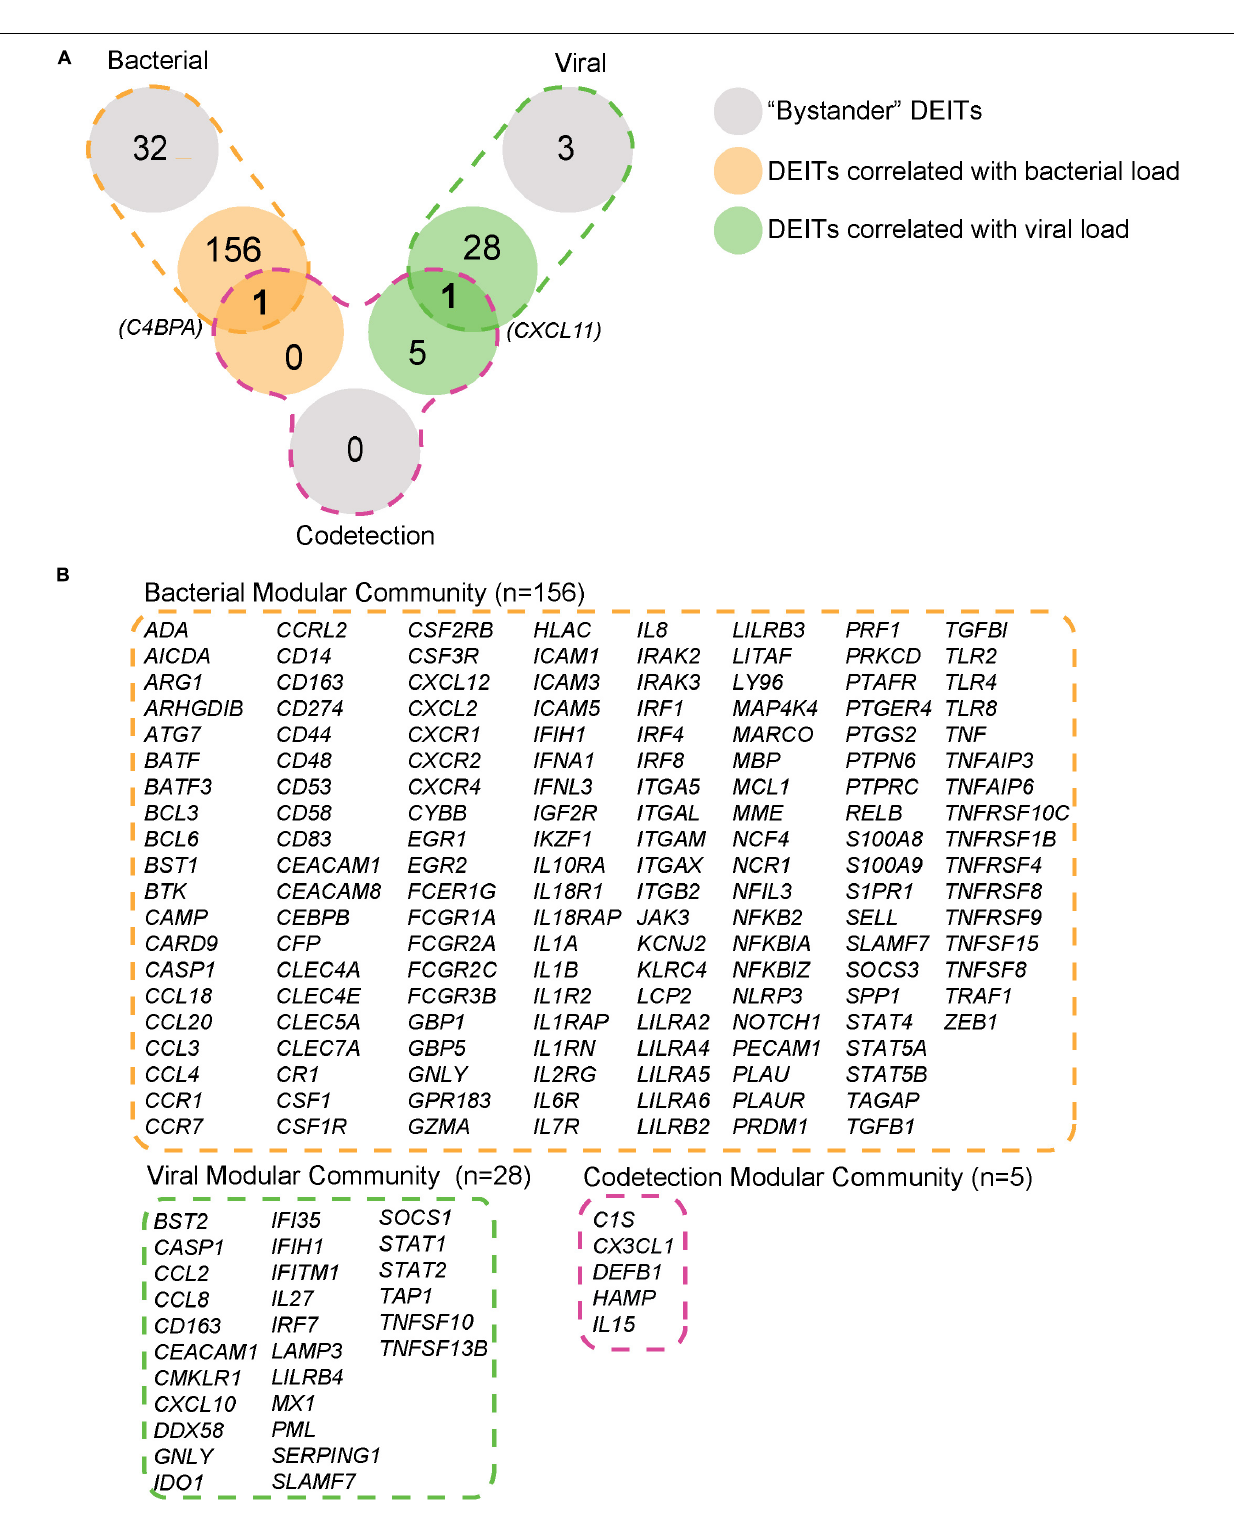
Frontiers in Microbiology |